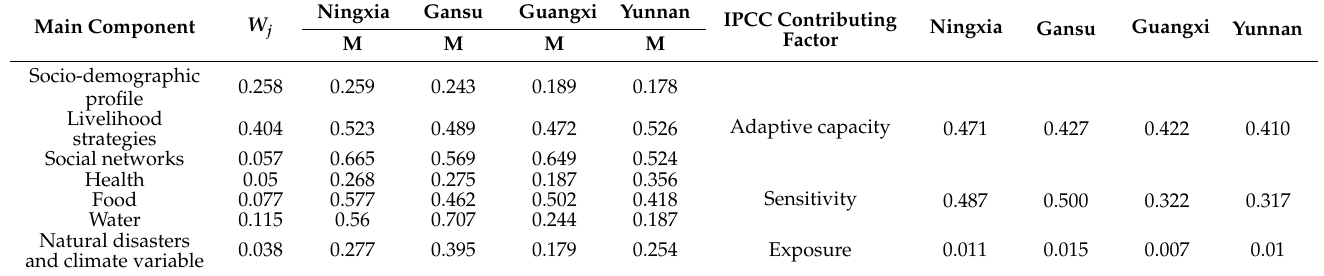
Table 5. The weight and score for main indicators and HLVI-IPCC value for Ningxia, Gansu, Guangxi, and